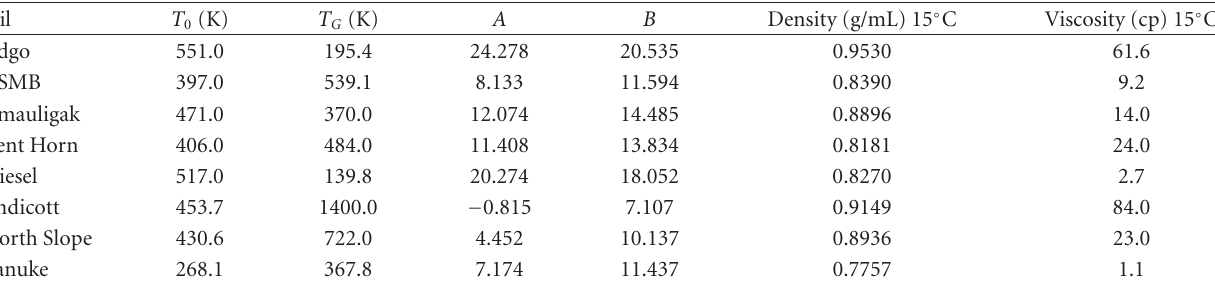
Table 1: Data from the Bobra evaporation experiments.